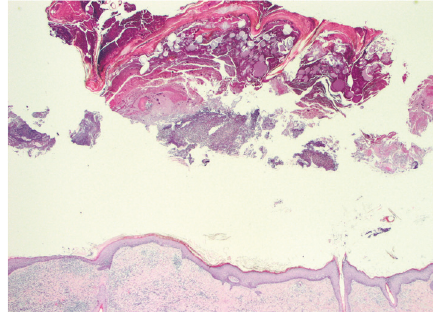
Figure 2: Excision revealed a variably atrophic epidermis with an impressive horn-like crust containing neutrophilic debris (H-E 2x).